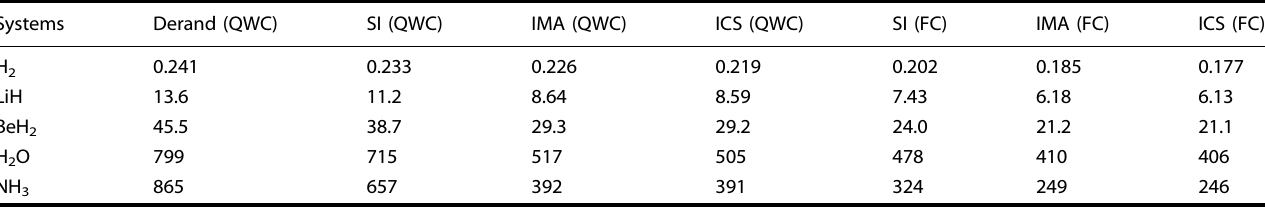
Table 5. Average estimator variances with random wavefunction and exact covariances. Systems Derand (QWC)